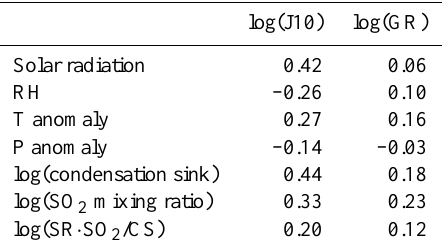
Table 2. Correlation coefficients between environmental factors with J10s and GRs on class I